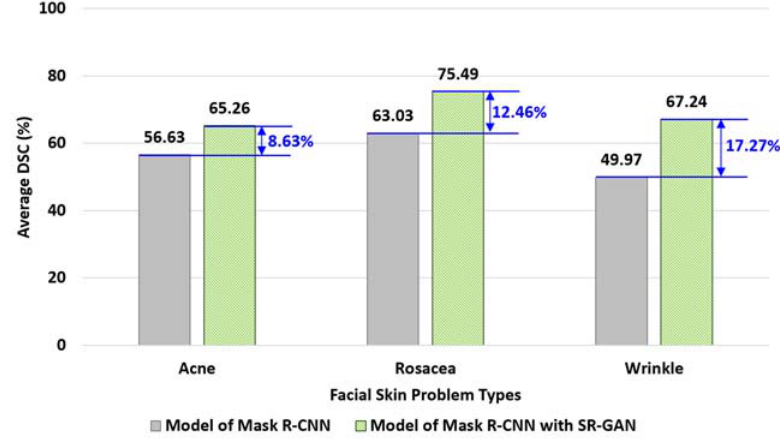
Figure 15. Comparing performances of segmentation with and without SR ‐ GAN.